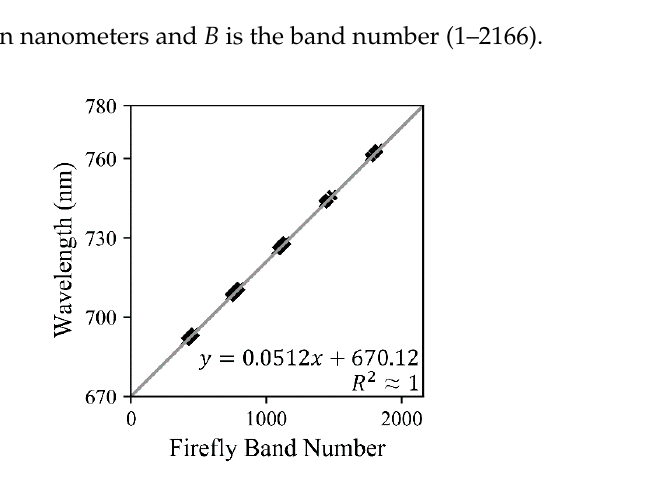
Figure 6. The relationship between FIREFLY band number and wavelengths (gray line) as established with GLAMR observations (black x).